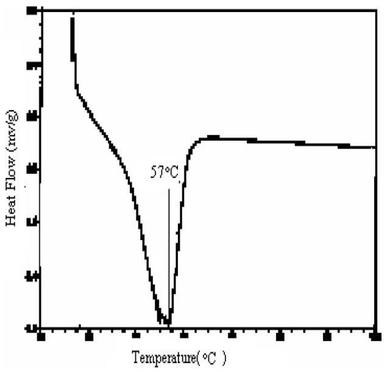
Absorption spectra of ATZC crystal.